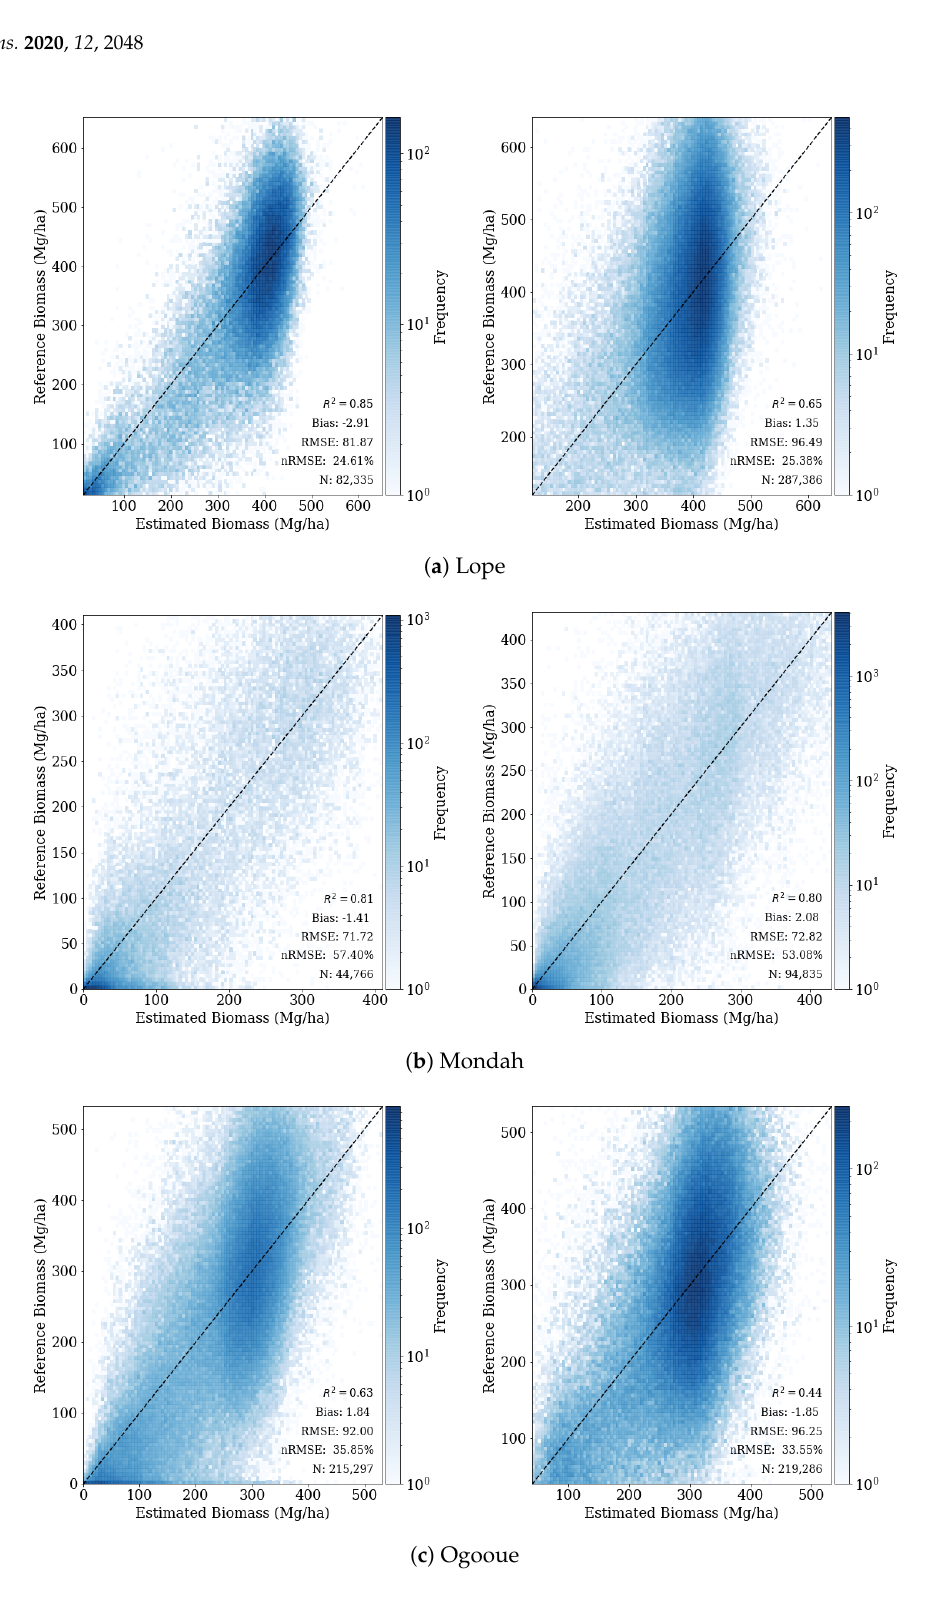
Figure 7. The results of training and validating our methodology on the full area. Left column is UAVSAR and right column is PALSAR-2 at 50 m